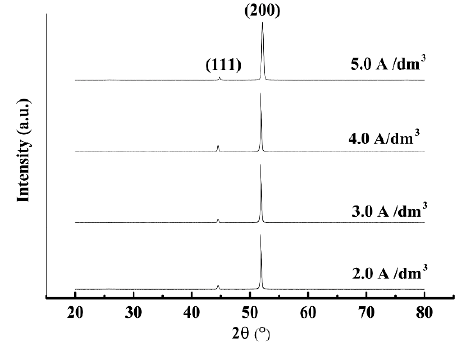
Figure 9. XRD pattern of the composite coating at various current densities.